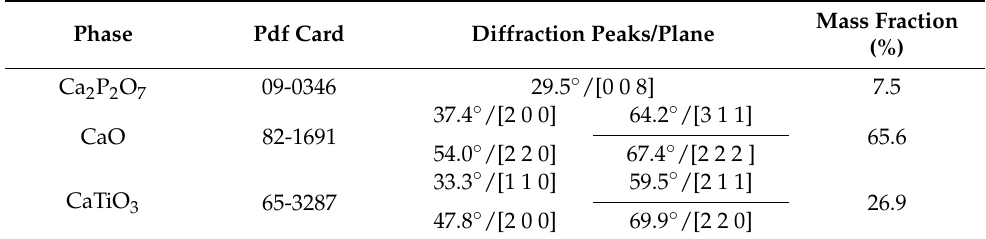
Figure 3. X-ray diffraction pattern of Ca/P ceramic coating top surface. Table 5. The phases of the coating surface and their corresponding diffraction peaks, crystal planes, and phase mass fractions (RIR